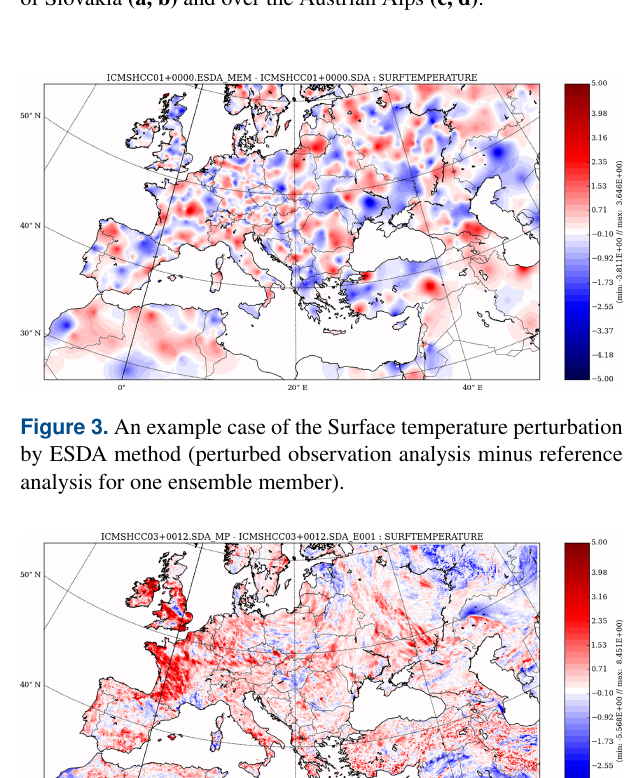
Figure 2. Model topography for current 11km grid (a, c) and new 5km resolution (b, d) zoomed over the Tatra mountains in northern part of Slovakia (a, b) and over the Austrian Alps (c, d) .